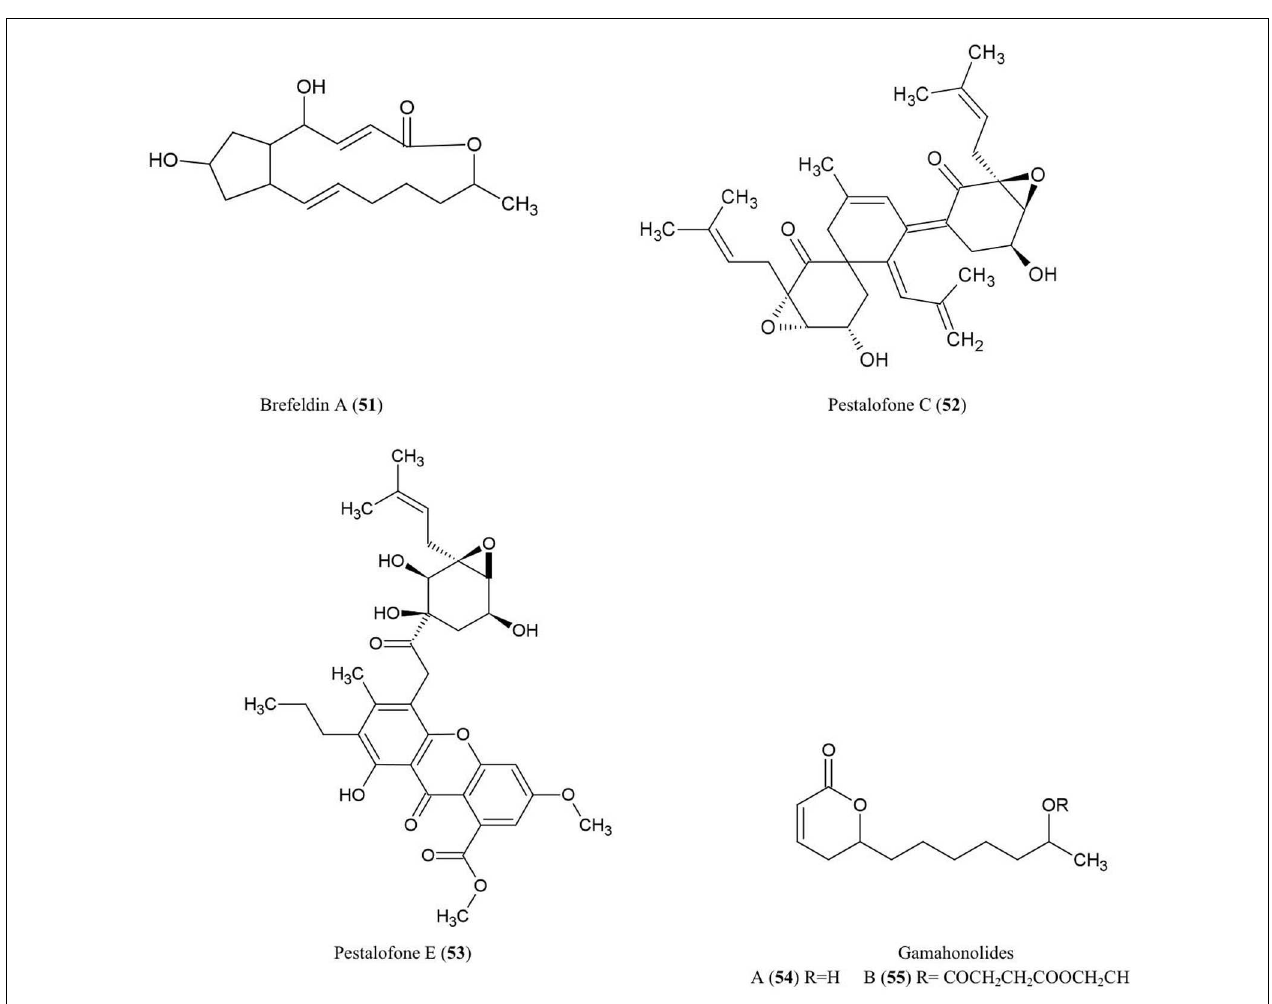
FIGURE 6 | Structures of aliphatic derivatives of fungal endophyte origin